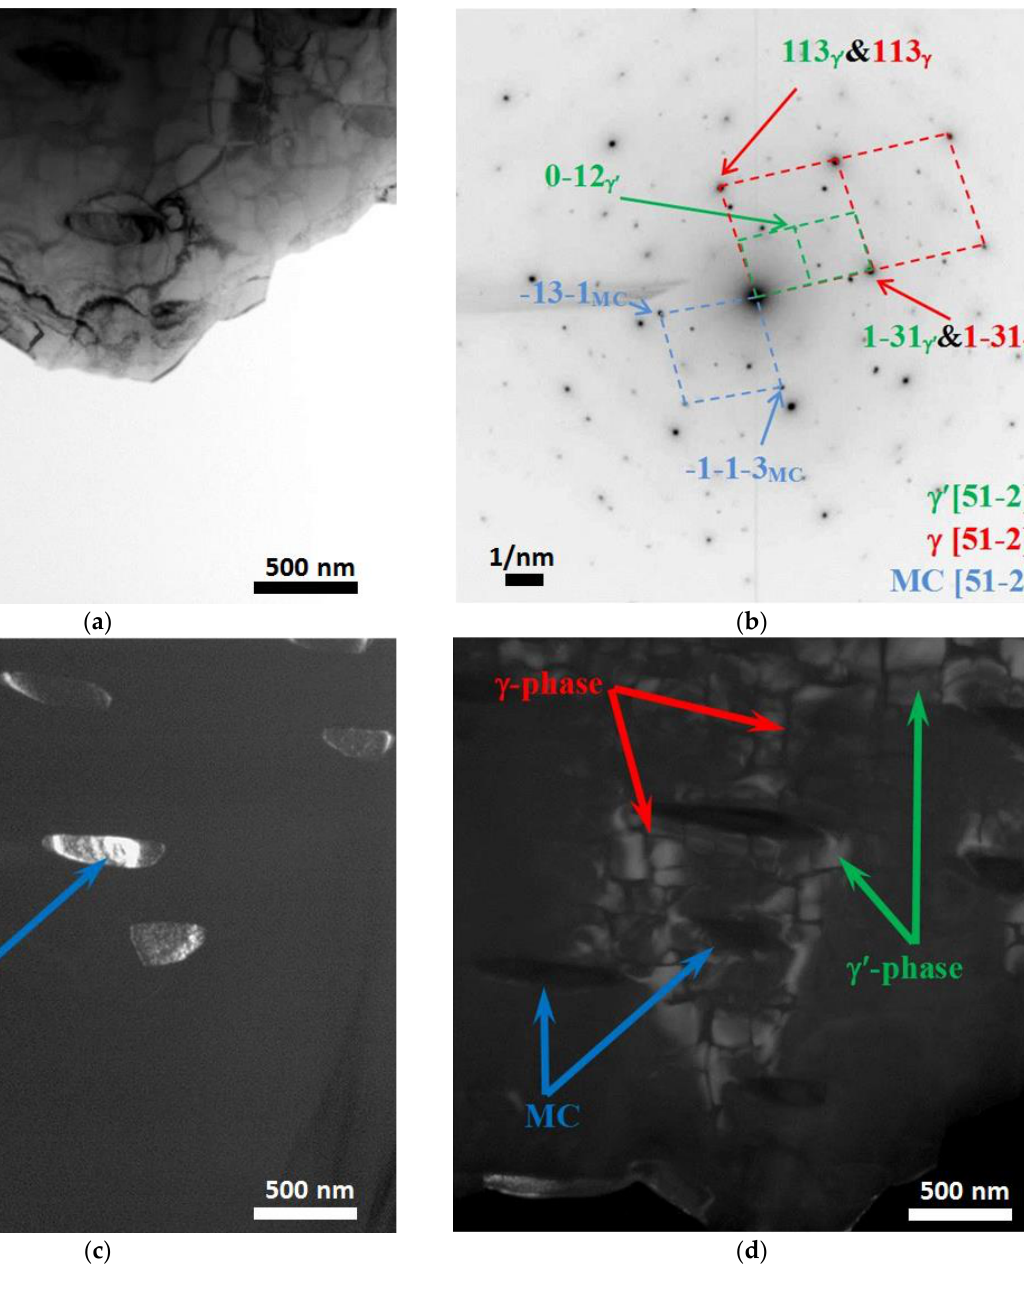
Figure 9. Fine structure of material of products obtained by wire-feed electron beam additive manufacturing at a distance from the substrate of 8 mm. Bright-field ( a ) and dark-field ( c , d ) TEM images, SAED and its identification scheme ( b ). Dark-field image taken in the reflection -13-1 MC ( c ) and 0–12 γ’ ( d ).